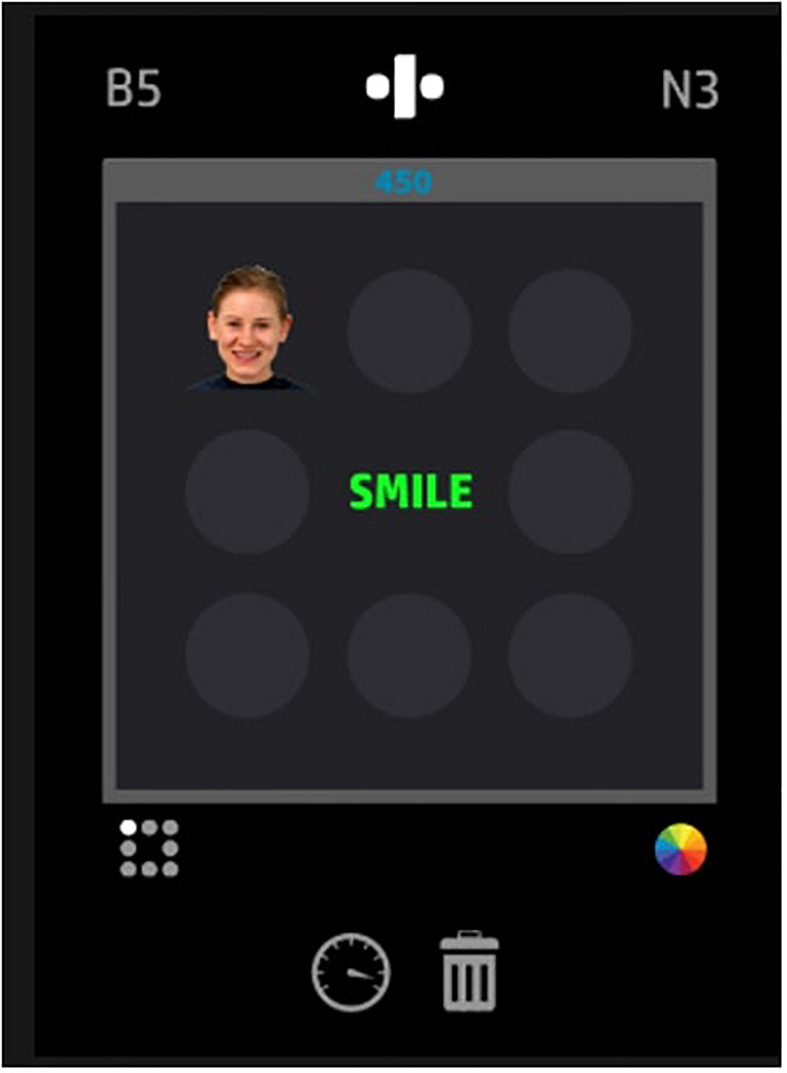
Working memory training game field (Smith, 2016).